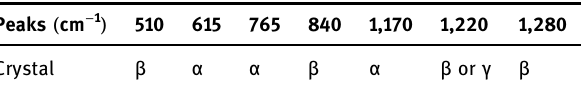
Table 3: Characteristic peaks of the PVDF structure in FTIR spectra [ 3,17,18,21,22 ]